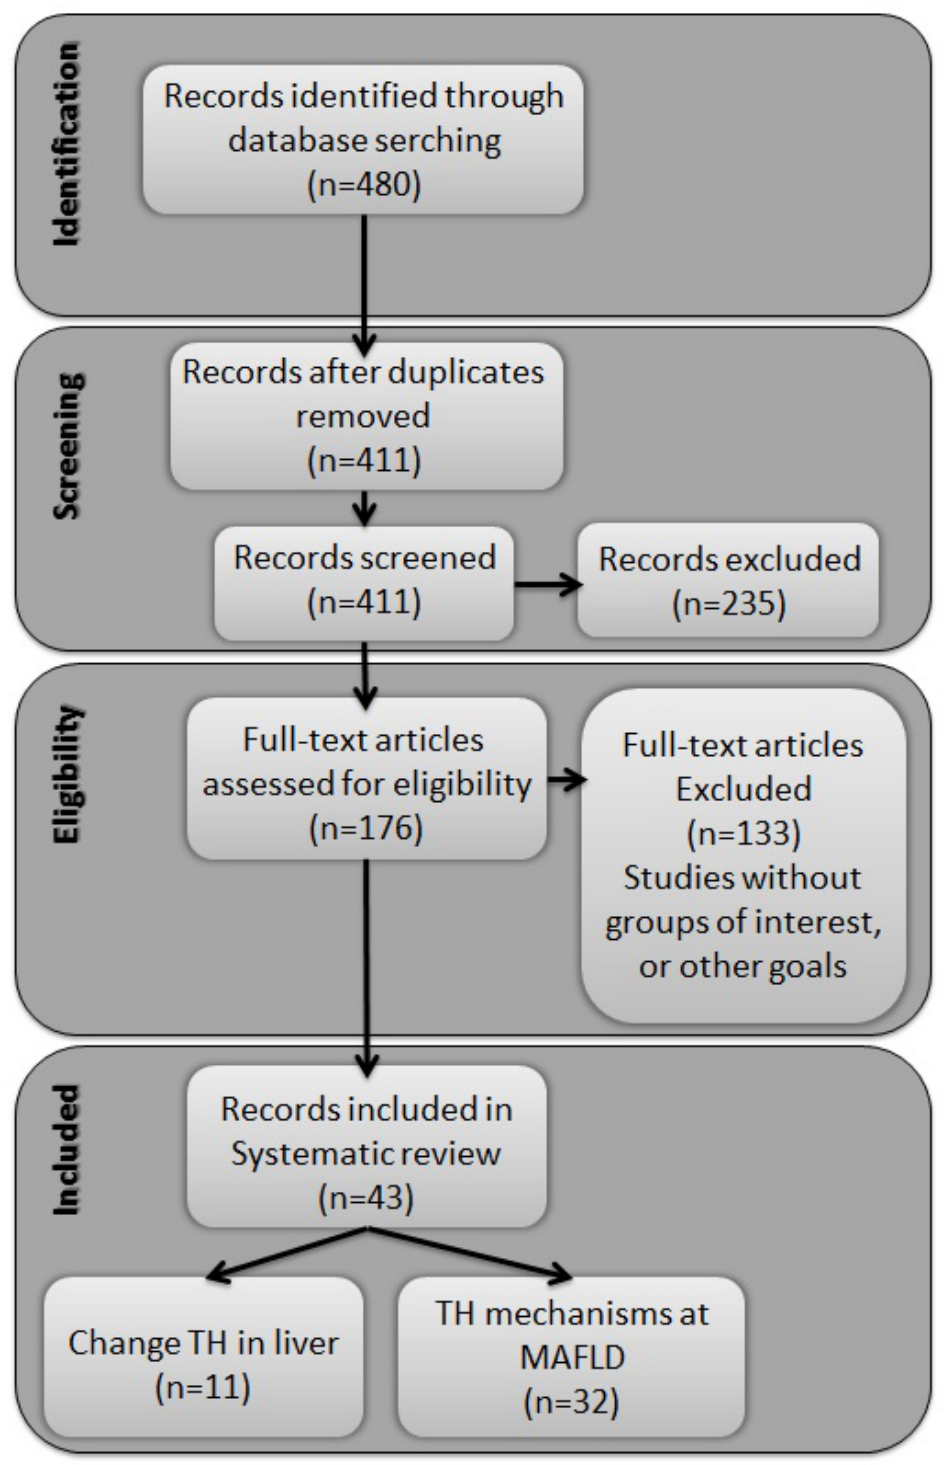
Figure 1. Flowchart of study selection.